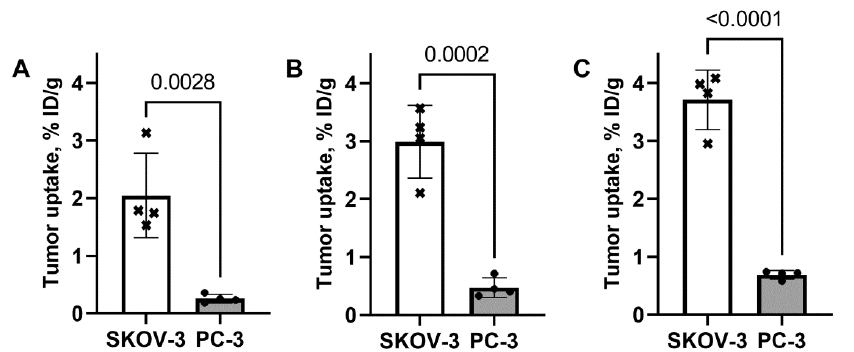
Figure 8. Uptake of [ 99m Tc]Tc-G3-G 3 C ( A ), [ 99m Tc]Tc-G3-(G 3 S) 3 C ( B ), and [ 99m Tc]Tc-(HE) 3 -G3 ( C ) in SKOV-3 (high HER2 expression) and PC-3 (low HER2 expression) xenografts in Nu/j mice 4 h p.i. Data are presented as mean %ID/g ± SD for four mice.